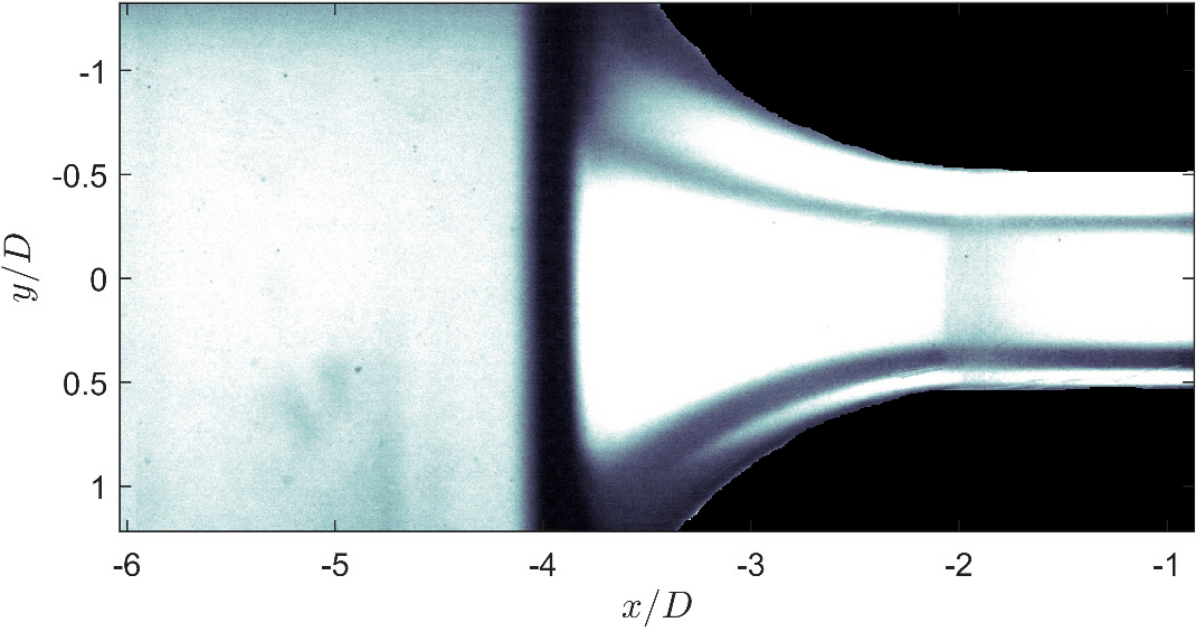
Figure 4. Image of the orifice inlet.